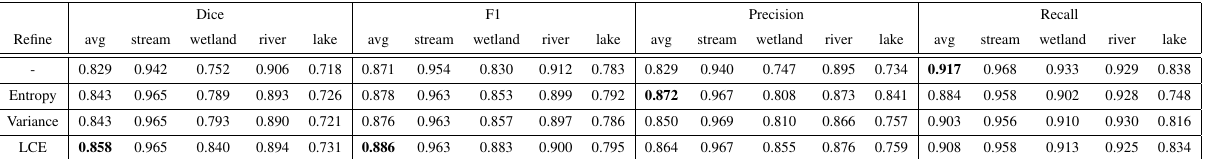
Table 2. Refinement using different uncertainty indicators. We calculate the dice, F1, precision, and recall to evaluate the accuracy in our testing areas for four classes - stream, wetland, river, and lake, and their average accuracy. designs clearly from normal designs. To test if the yielded un- certainty is highly structured and meaningful, we have proposed a two-stage network to use the uncertainty to refine raw predic- tions (the second stage) from a normal segmentation network (the first stage). The aid of ensemble variance that captures epi- stemic uncertainty does not lead to a greater improvement than the other two indicators for aleatoric uncertainty, possibly be- cause noise in data dominates predictions more systematically in our case. Among all three indicators, LCE shows the greatest performance in the refinement task. However, none of the in- dicators is able to capture the uncertainty in context. In the future, we are going to investigate the impact of context-level uncertainty on model